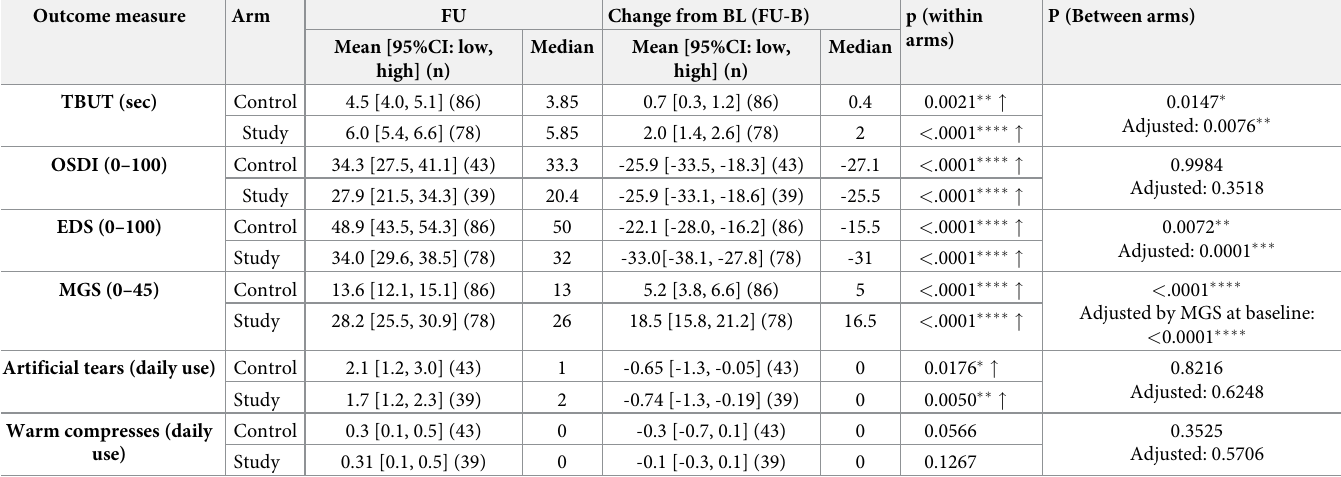
For all variables, the value at FU and the change from BL to FU are represented with Mean and the 95% confidence interval ( μ [Low 95%, High 95%]), and the median. Within each arm, p tests the null hypothesis that there is no change between BL (Table 1) and FU (two-sided paired t-test). P tests the null hypothesis that the change is similar between the two arms (least squares fit). For eye level variables (TBUT, EDS and MGS), correlation between eyes was removed as explained in Methods.